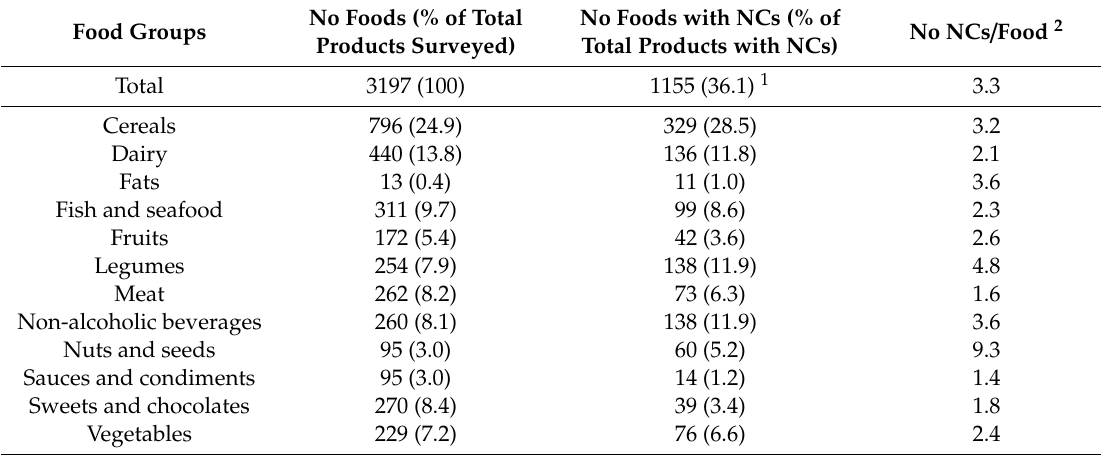
Table 1. Number of foods and nutrition claims (NCs) by